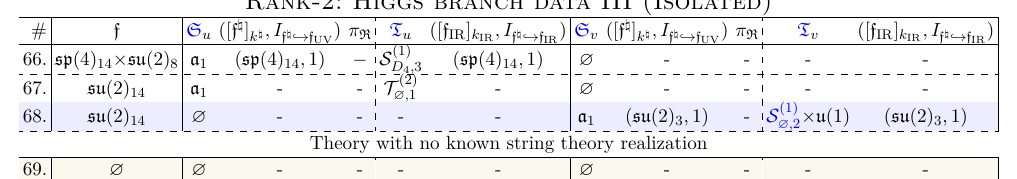
Table 8. This table summarizes the HB data for the isolated theories. The second column lists the flavor symmetry of the SCFT, column three to seven, lists the information of the higgsing of the flavor symmetry realized on the CB unknotted stratum u = 0 , while the last four columns present the same information for v = 0 . For more details and an explanation of the connection with generalized free fields realization of the theory’s VOA, see appendix C. u (1) factors in this table will be mostly